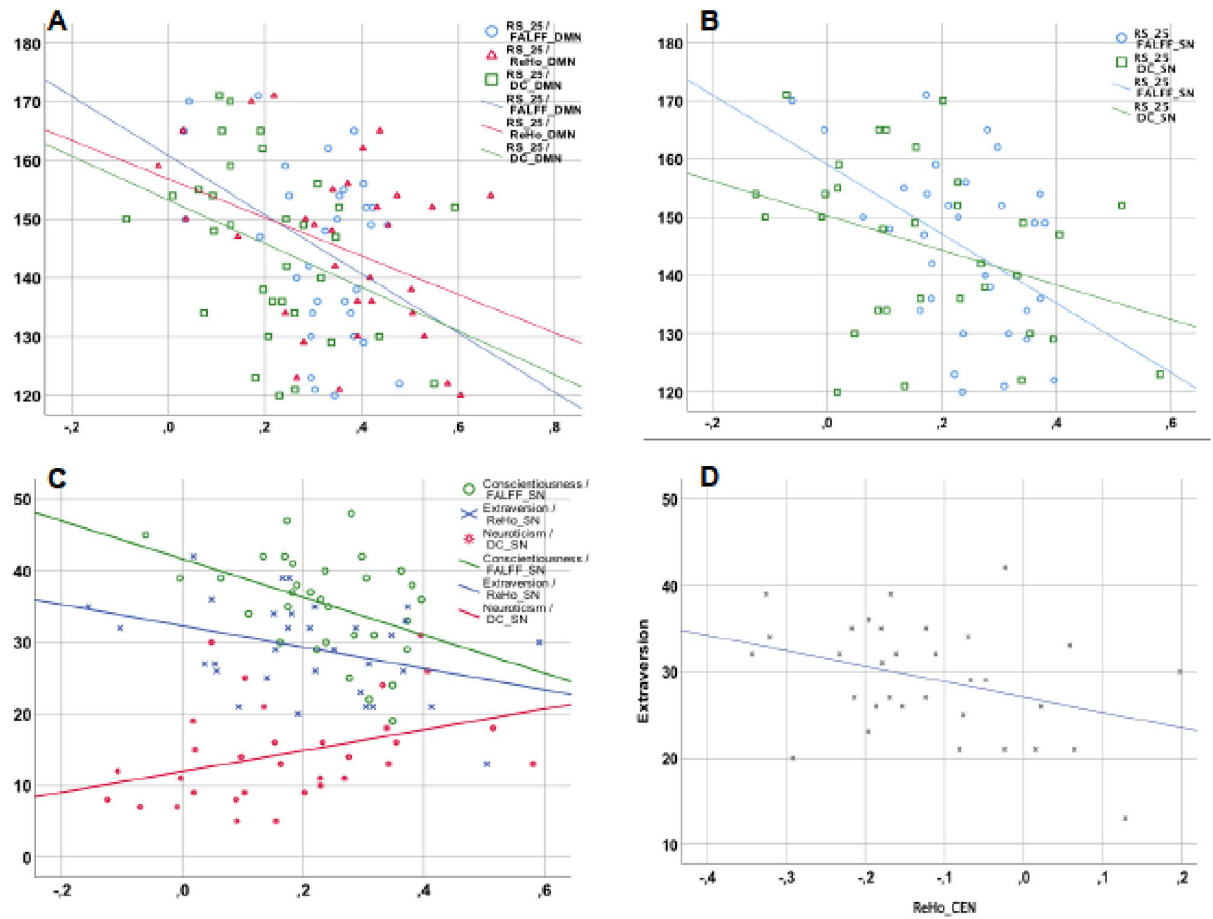
Figure 5. ( A ) Correlations between RS-25 and the fMRI metrics in the DMN. ( B ) Correlations between the RS-25 and the fMRI metrics in the SN. ( C ) Correlations between three personality traits